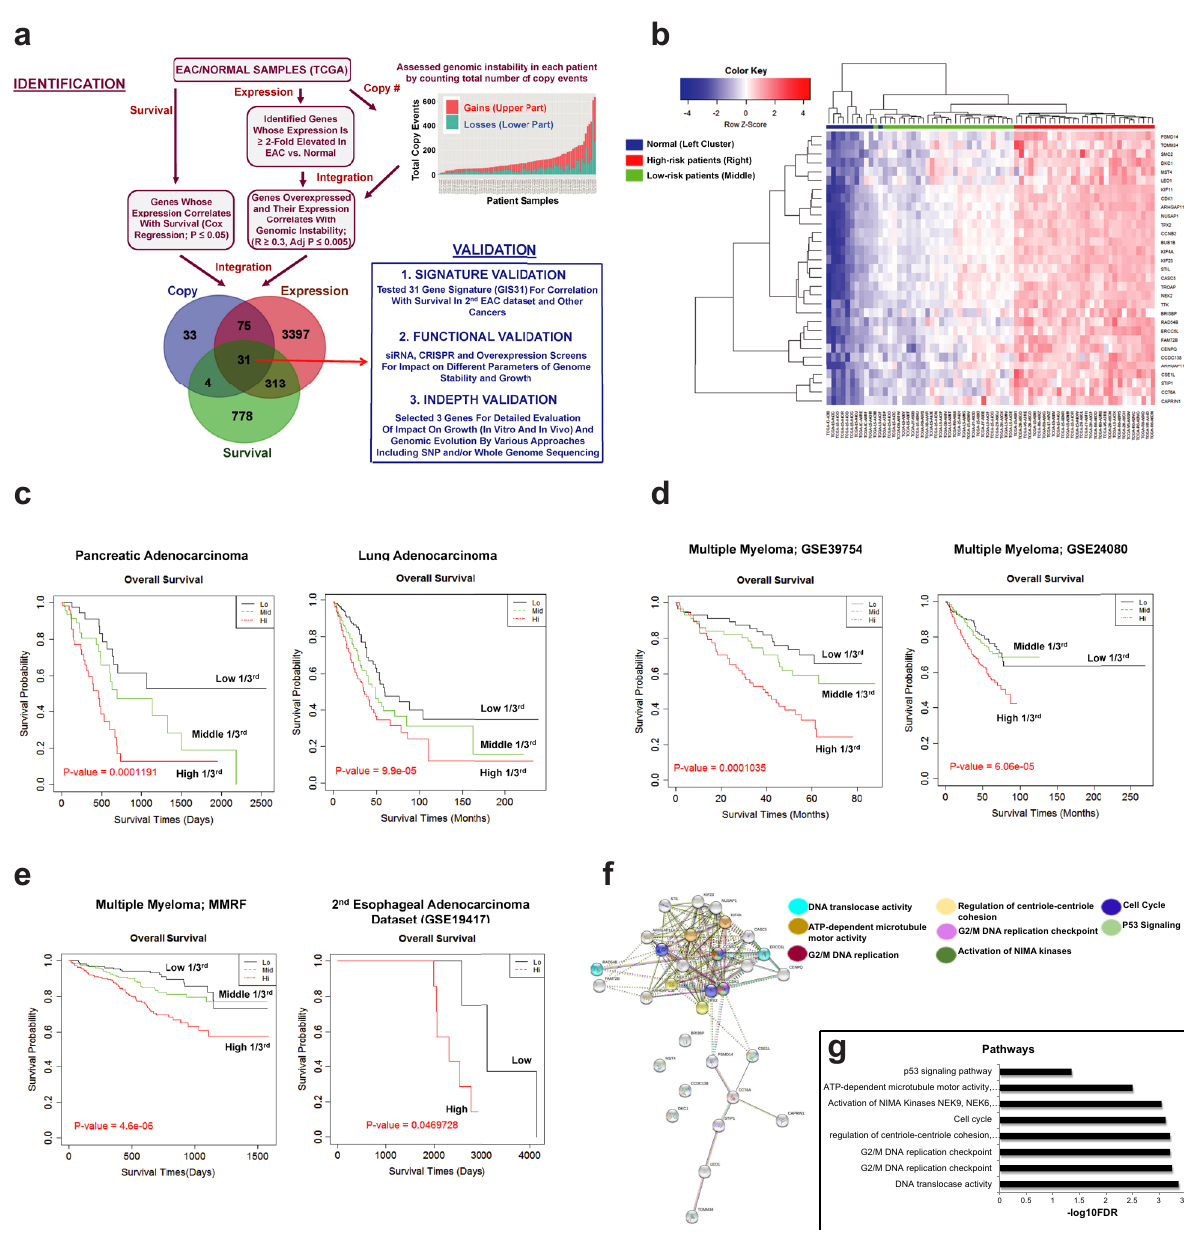
Fig. 1 Identi fi cation of drivers of genomic evolution in EAC. a Experimental design. Stepwise process involved in the identi fi cation and validation of genes. Identi fi cation: (1) assessed gene expression in 11 normal and 88 EAC patient samples in TCGA dataset and identi fi ed genes that were overexpressed in EAC; (2) asessed genomic instability in patient samples by counting total number of copy events in each patient. Total copy number events in each patient are shown as bar graph in Fig. 1a; each bar shows ampli fi cations (red or upper part of bar) and deletions (green or lower part of the bar). Genomic instability data were then integrated with expression data to identify genes that were overexpressed in EAC and whose expression correlated with genomic instability; (3) evaluated resulting genes for correlation with survival. This led to identi fi cation of 31 genes that were overexpressed in EAC and whose expression correlated with genomic instability and overall survival in EAC patients in TCGA dataset. Validation: describes plan for functional validation of genes: (1) the expression of 31 gene signature was tested for correlation with survival in a second EAC dataset and in other cancers; (2) conducted siRNA, CRISPR/Cas9, and overexpression screens for impact on different parameters of genome stability and growth; (3) selected three genes for detailed evaluation of impact on genomic evolution by various approaches including SNP and/or whole genome sequencing; (4) evaluation in SCID mice. b Heat map shows that expression of 31 genes is high in EAC patients with poor overall survival (red bar) and low in patients with relatively better survival (green bar) (in TCGA dataset), and also low in normal samples (blue bar). c – e Elevated expression of 31 gene signatures (identi fi ed in TCGA patient dataset) correlated with poor overall survival in pancreatic and lung adenocarcinoma ( c ), multiple myeloma datasets GSE39754 and GSE24080 ( d ), and multiple myeloma MMRF (Multiple Myeloma Research Foundation) dataset and second esophageal adenocarcinoma dataset (GSE19417) ( e ). f Interconnectivity among the GIS31 genes (based on STRING networks) is shown by lines and the shared functional roles of these genes in different pathways are indicated by different colors. g The pathways shown in f are also shown as bar